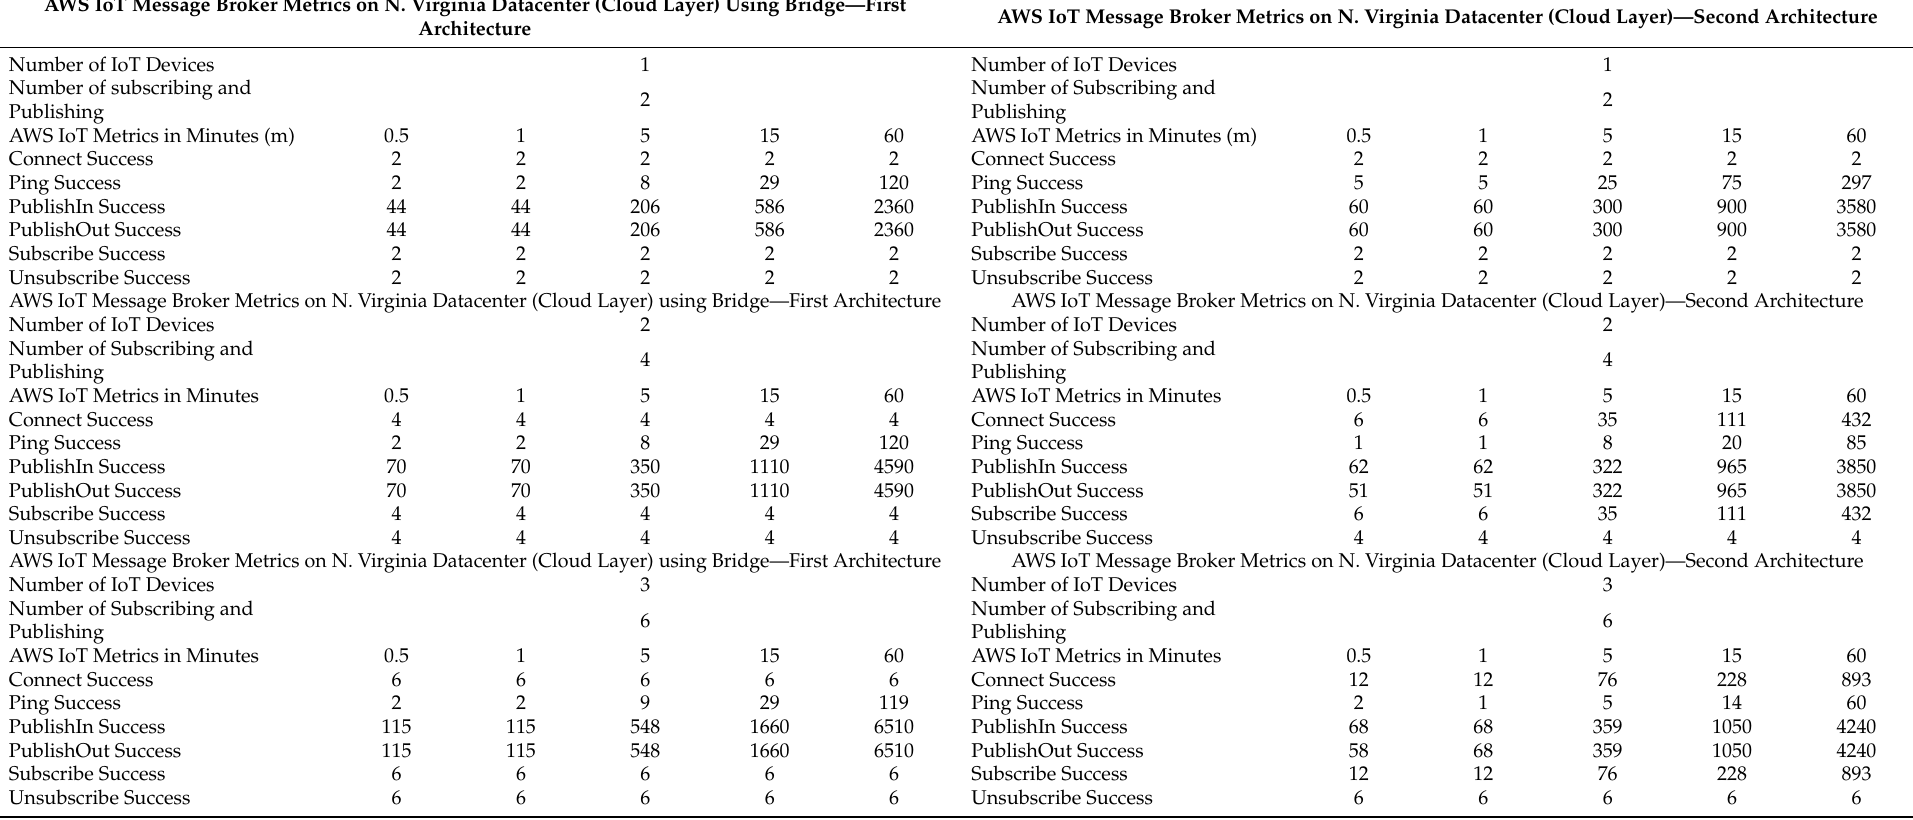
Table 2. AWS IoT message broker metrics for the North Virginia datacenter (cloud layer) using a bridge—first and second